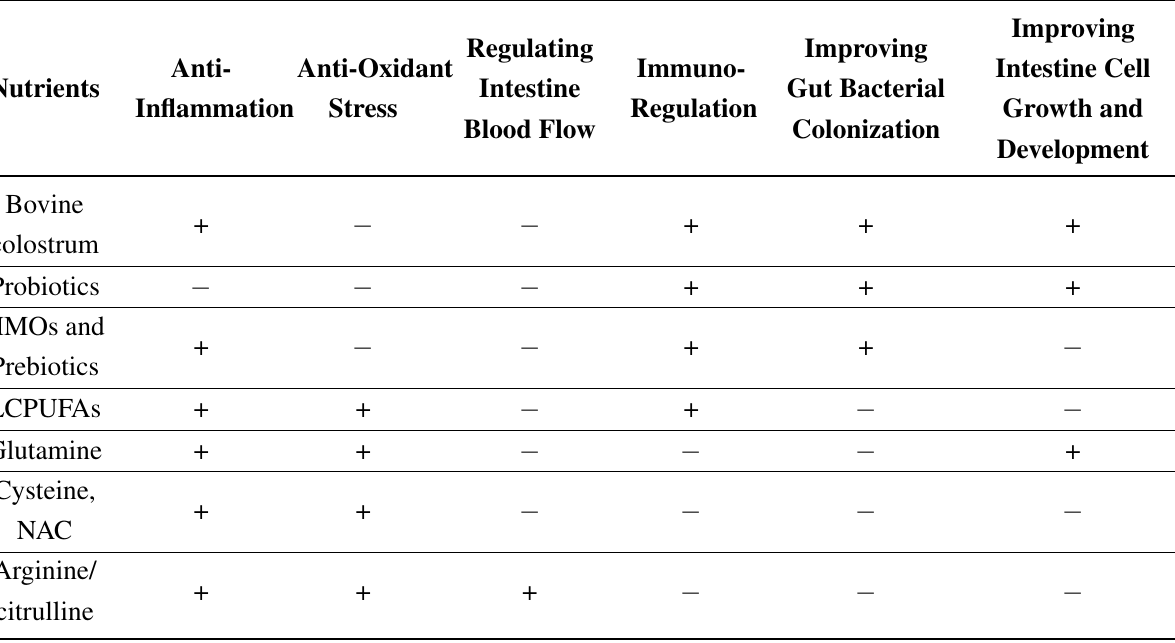
Table 1. NEC-preventive